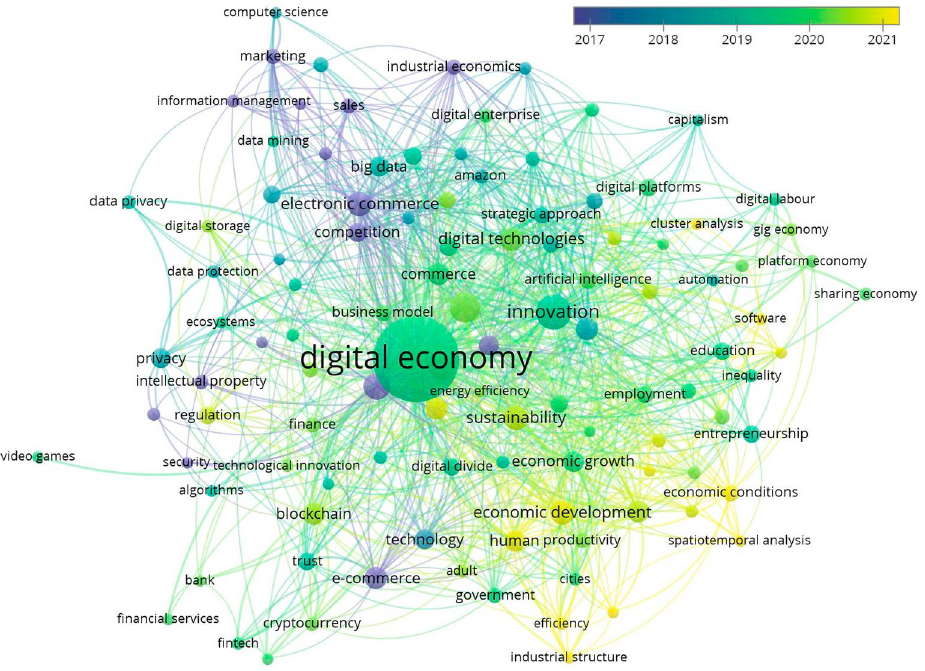
Figure 5. The overlay visualization map of core scientific clusters in researching